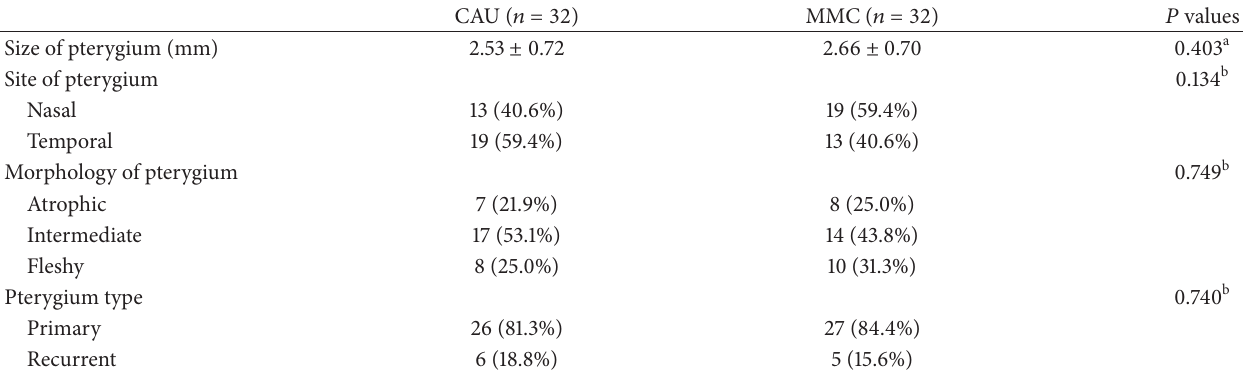
Table 2: Preoperative Characteristics of Pterygium in the Conjunctival Autograft and Mitomycin C Groups Who Completed 12-tear-follow-